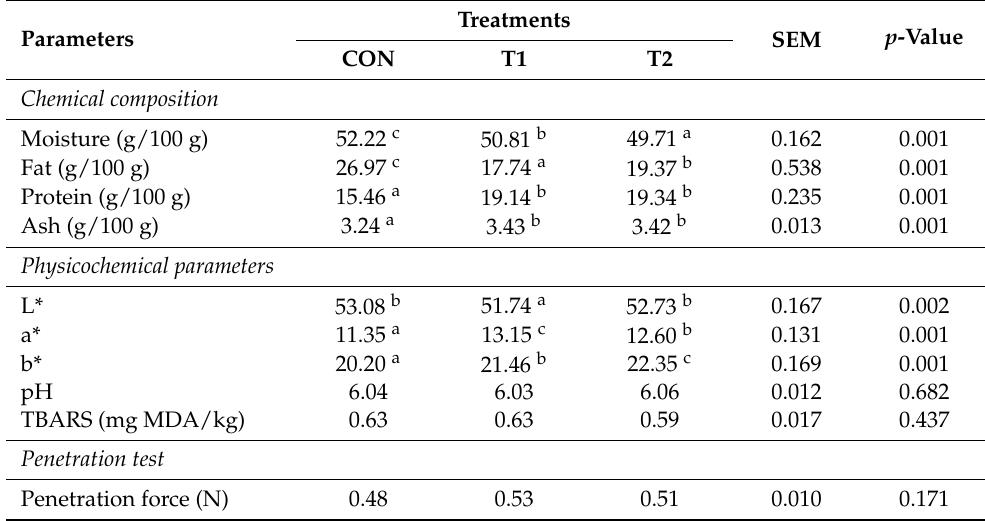
Table 3. Proximate composition, lipid oxidation and physicochemical properties of foal p â t é s. Parameters